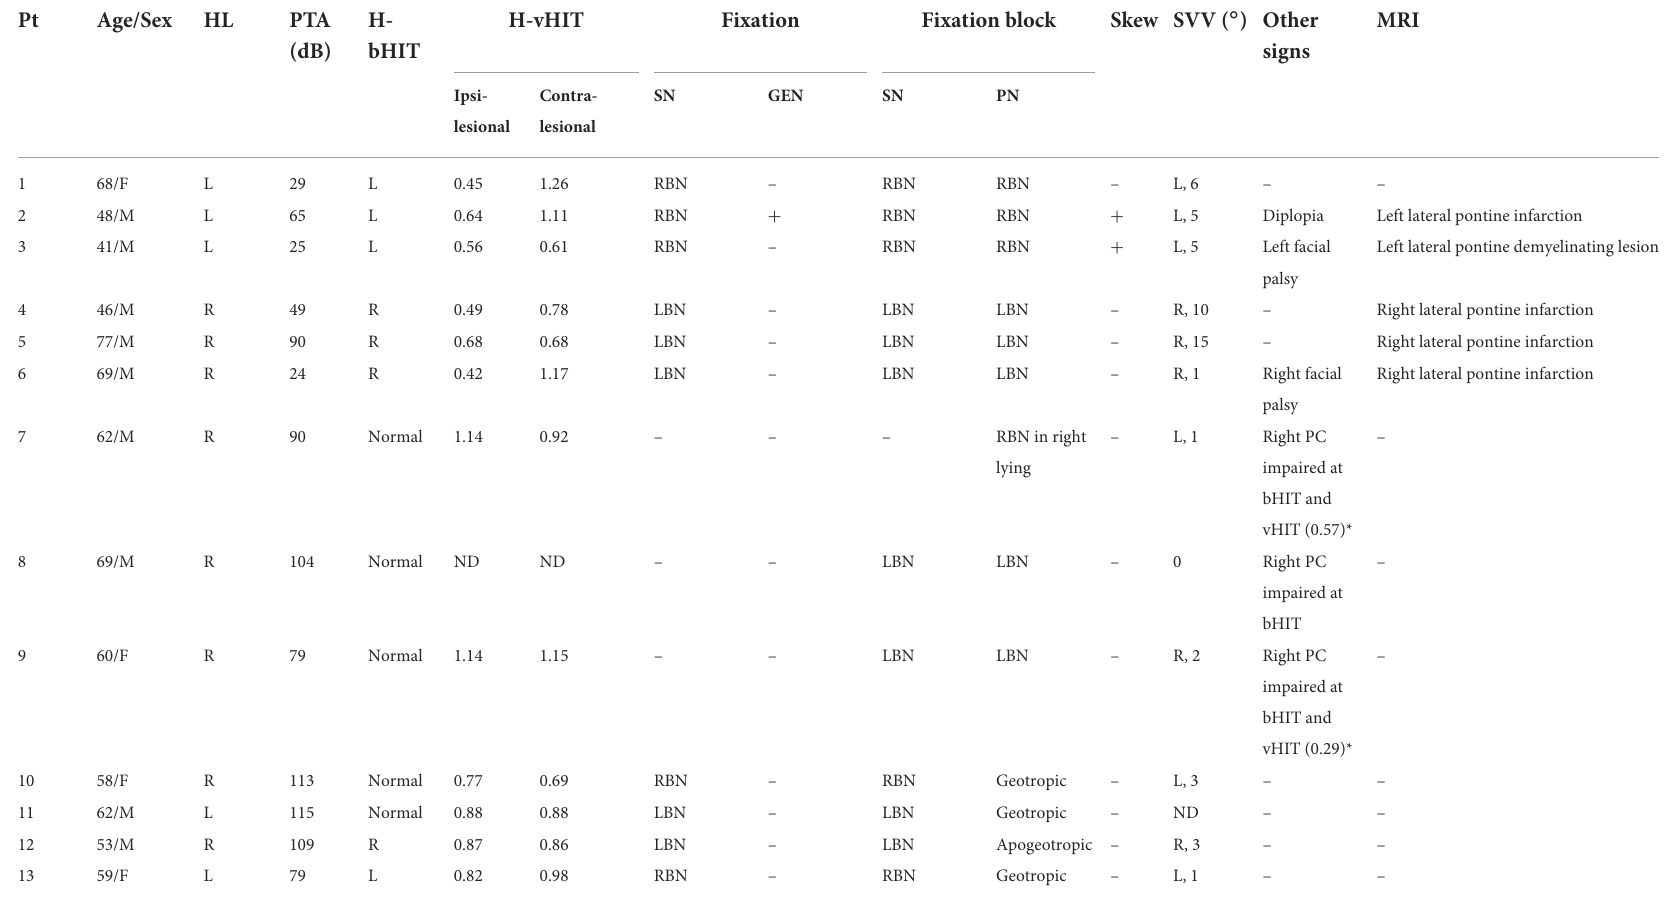
TABLE 1 Clinical and neuro-otologic findings in the patients with acute vestibular syndrome plus hearing